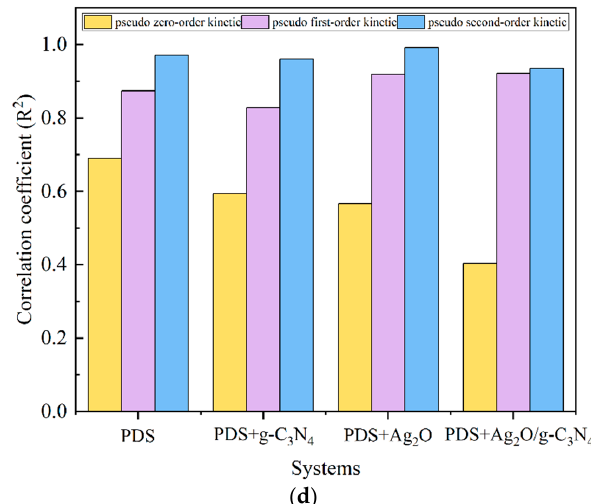
Figure 6. Determination of kinetic rate constants for MO degradation under different activation systems. ( a ) Determination of zero-order kinetic rate constants for MO degradation under different activation systems. ( b ) Determination of pseudo-first-order kinetic rate constants for MO degradation under different activation systems. ( c ) Determination of pseudo-second-order kinetic rate constants for MO degradation under different activation systems. ( d ) Correlation coefficients (R 2 ) of different kinetic models of MO degradation under different activation systems. Table 1. Kinetic parameters of reaction for MO degradation under different activation systems. ( a ). Pseudo ‐ first ‐ order kinetic parameters for MO degradation under different activation systems. ( b ). Pseudo ‐ second ‐ order kinetic parameters for MO degradation under different activation systems.